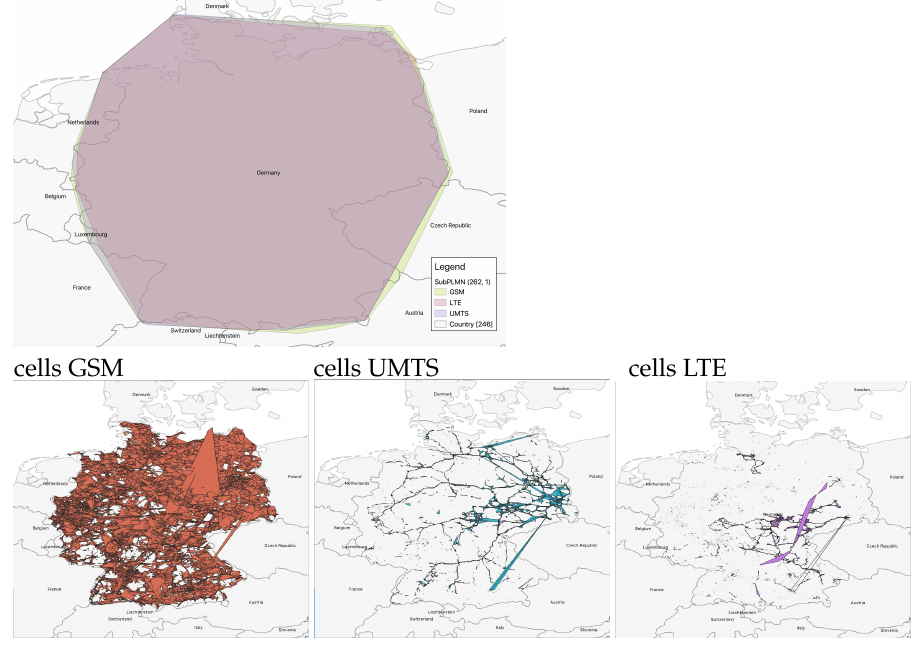
Figure 15. Coverage of different technologies by the same PLMN: mcc=262 (Germany) and mnc=1 . Administrative areas . Proceeding down the hierarchy of the network, we find the logical grouping of cells represented by administrative areas. These play a major role in localiza- tion at a coarser granularity, as described in [37–39]. Some works [37,40,41] point out